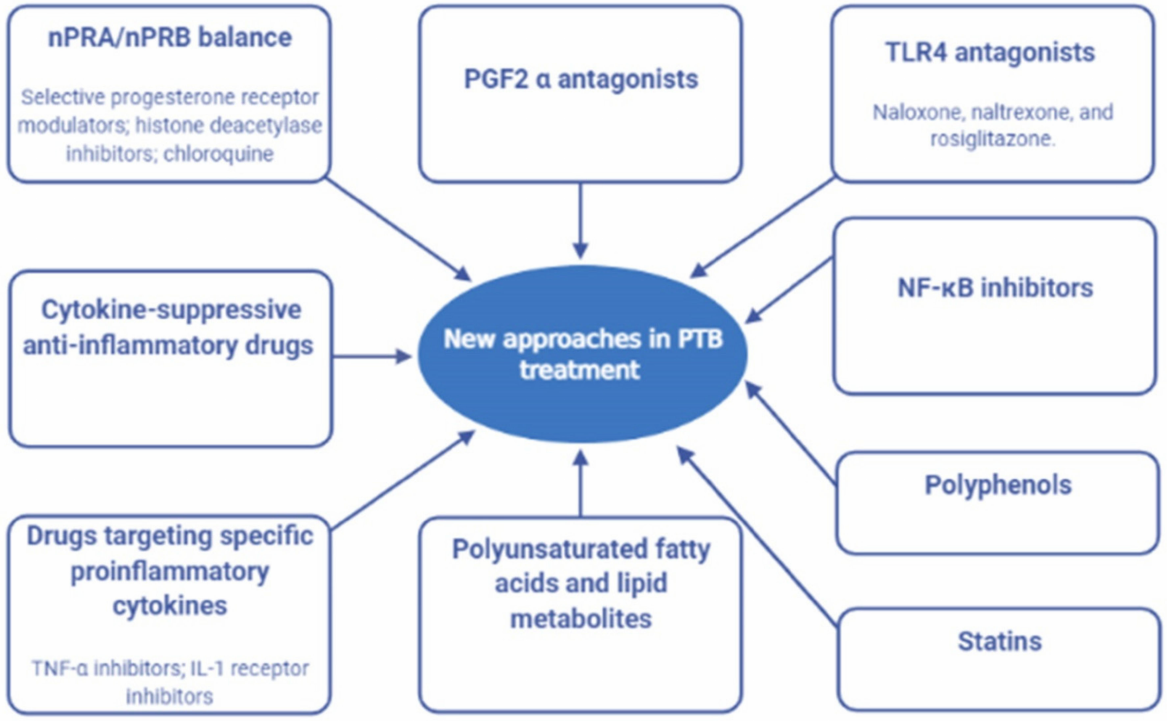
Figure 3. Investigational treatments in preterm birth (PTB). Created with BioRender.com (accessed on 3 February